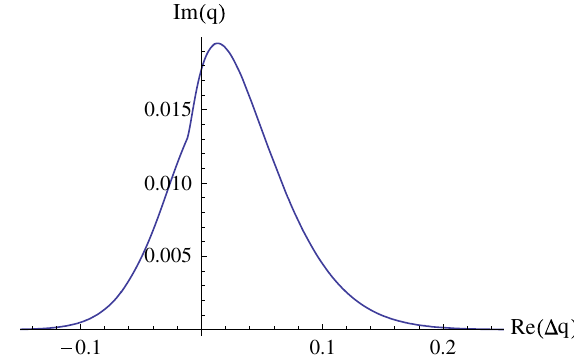
FIG. 13. Stability diagram for LHC octupoles at their current